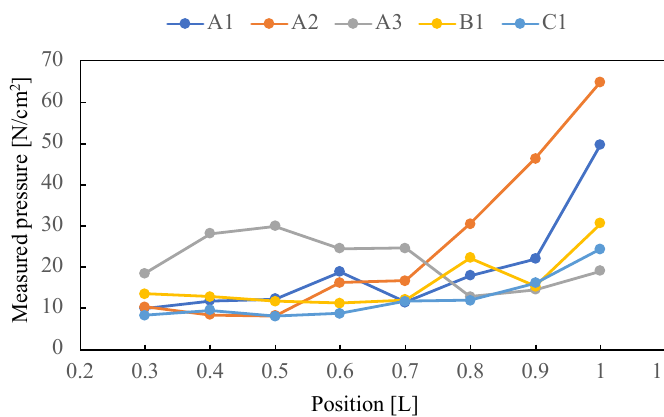
Figure 11. Lateral sum of comfort measured pressure.